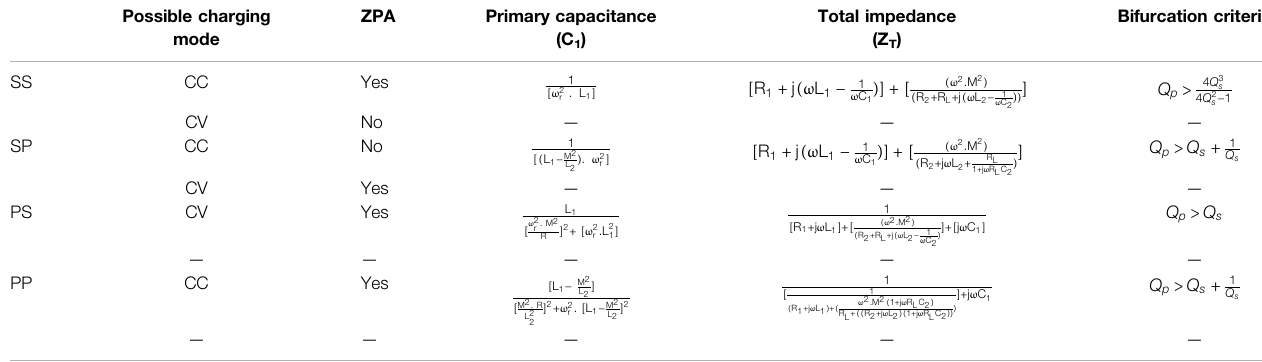
TABLE 6 | Equations involved in basic compensation topology networks. Possible charging